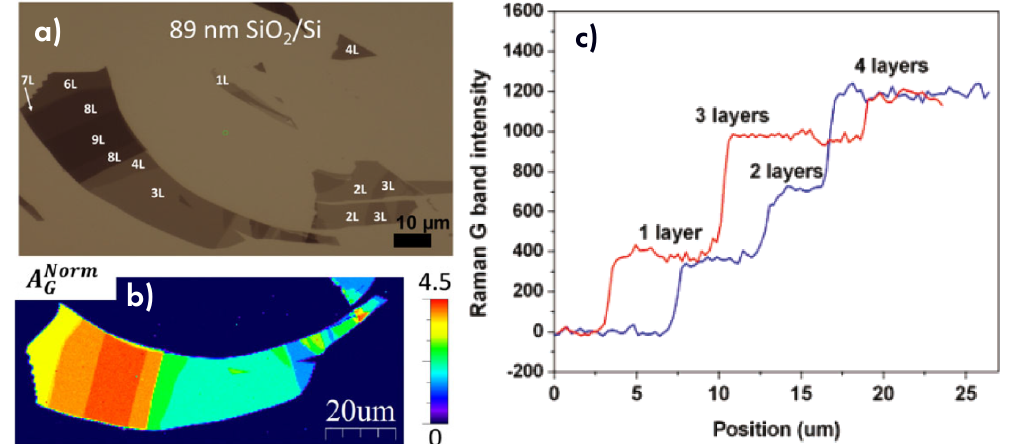
Figure 18. Evolution of ( a ) optical contrast and ( b , c ) G band intensity of graphene by increasing the number of layers. Panels ( a , b ) are reprinted with permission from Ref. [68]. Copyright (2018) Wiley. Panel ( c ) is reprinted from Ref. [67]. Copyright (2007) American Chemical Society.